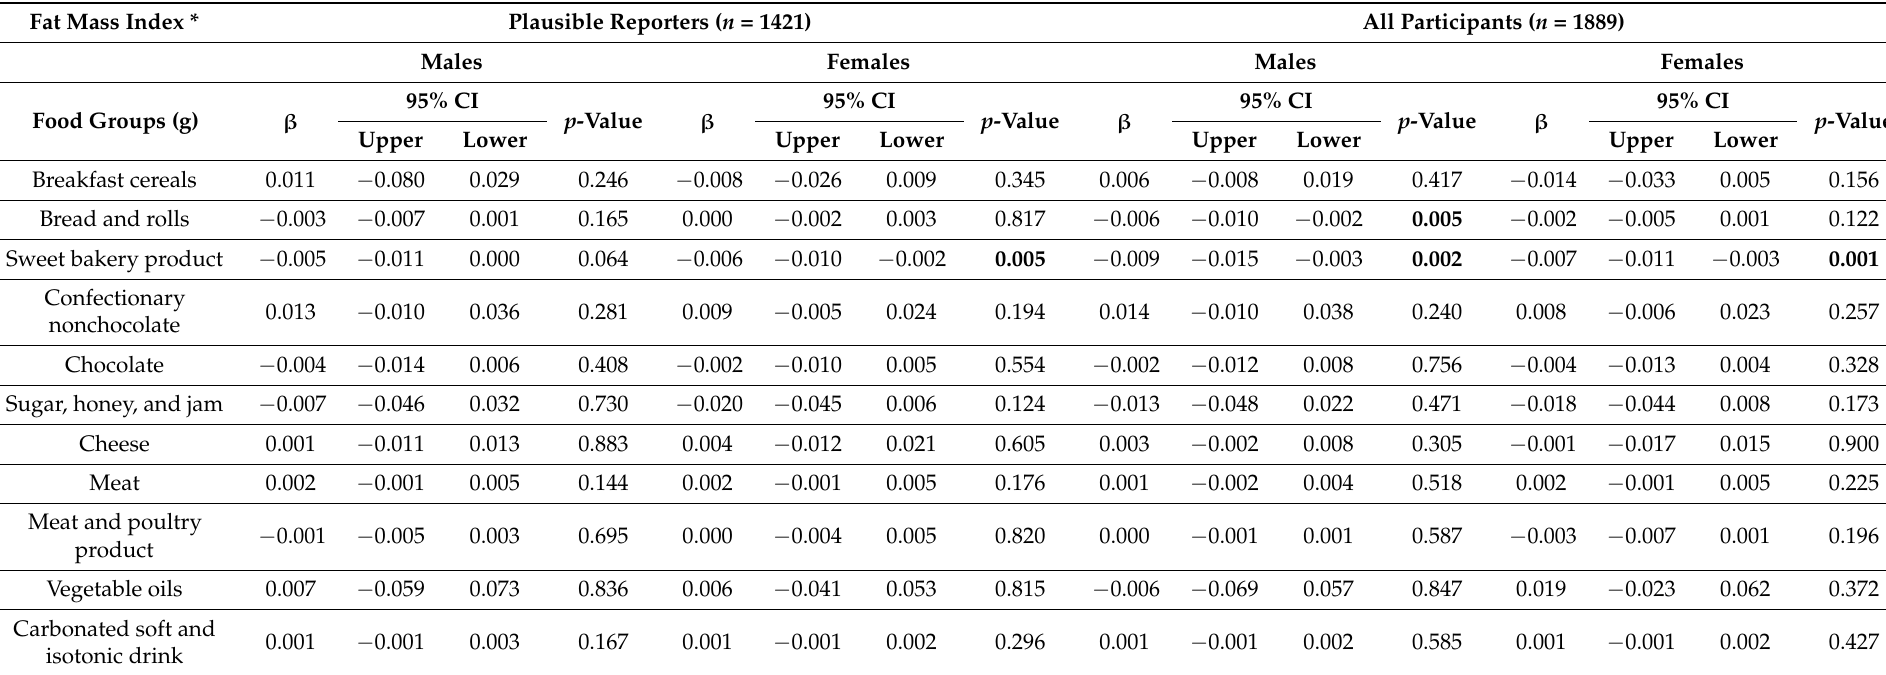
Table 4. The association between FMI and portion size of most ED food between gender using multiple linear regression